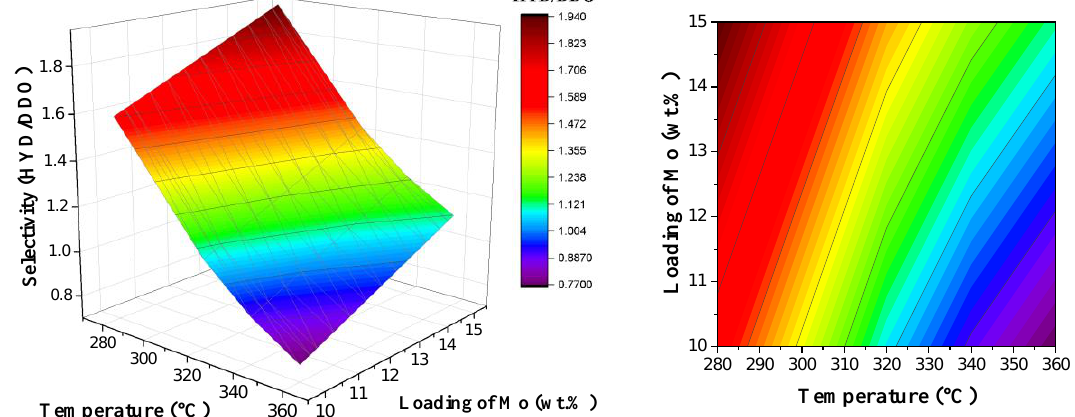
Figure 7. Response surface curve ( left ) and contour plot ( right ) correspond to selectivity as a function of Mo loading and temperature for the HDO of phenol over CoMo/AT2.